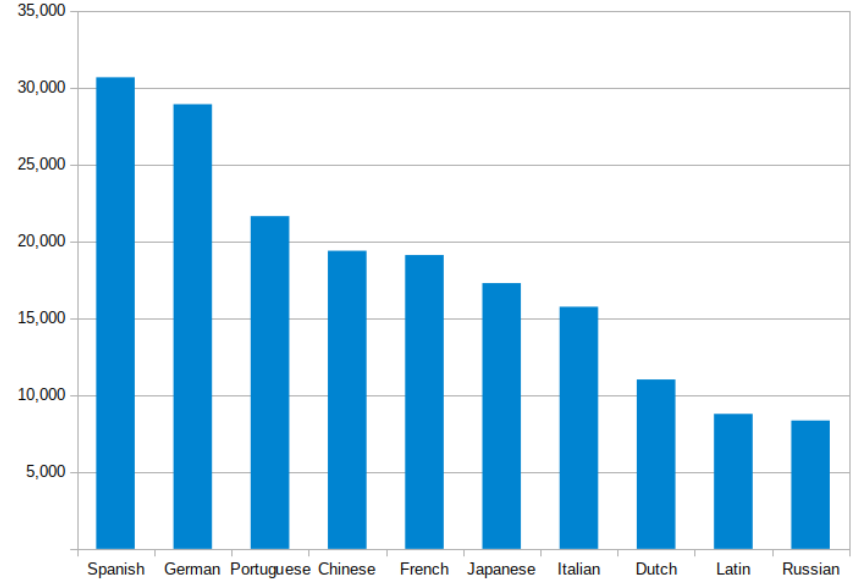
Figure 5. The distribution of links that refer to non-English language